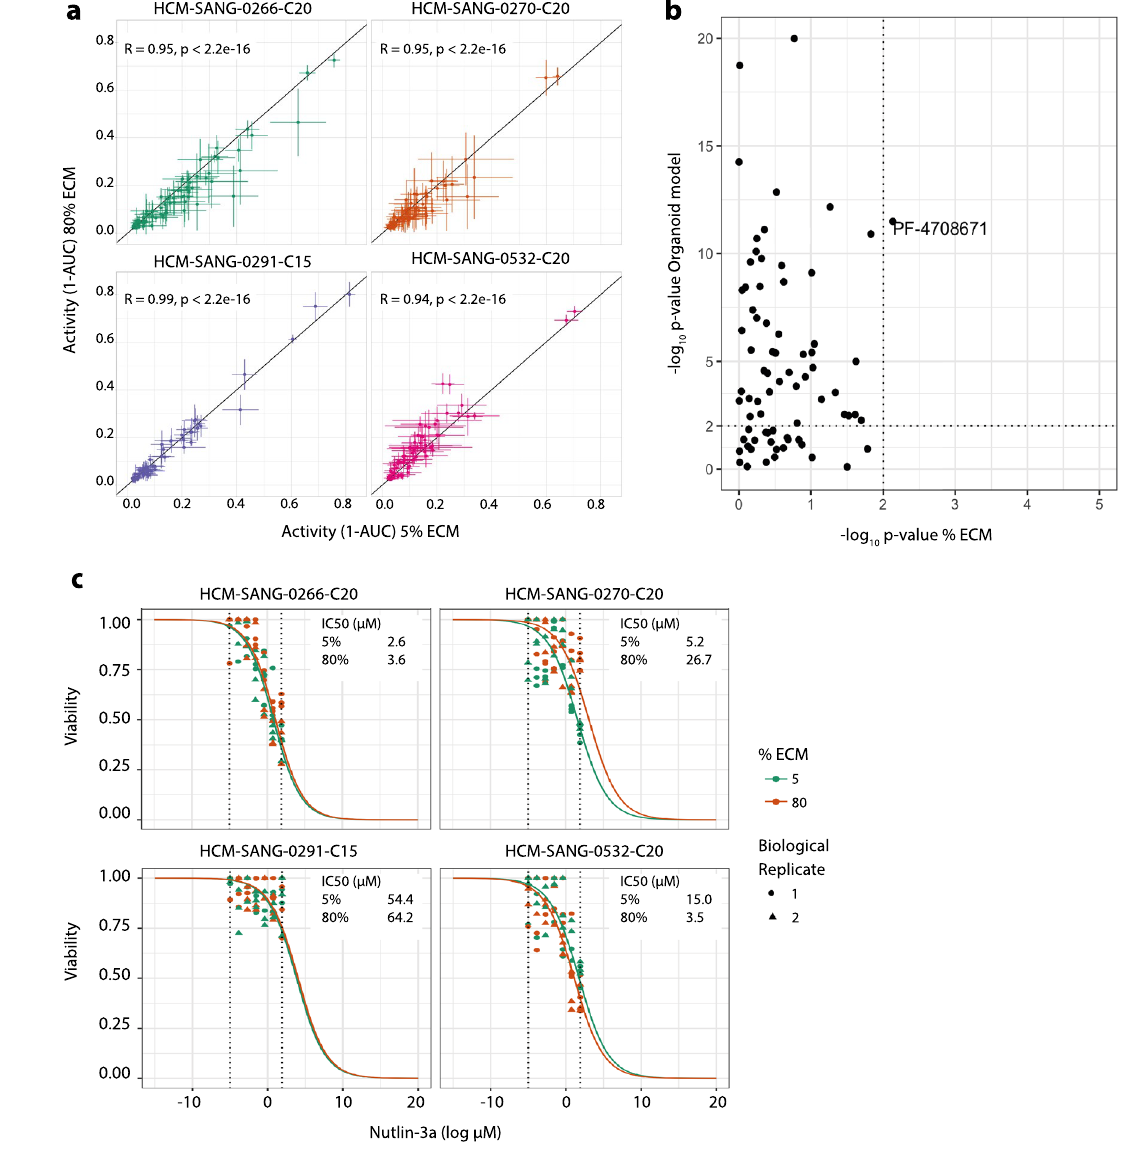
Figure 4. Drug response in standard vs 5% ECM conditions. ( a ) Sensitivity of four organoids to 72 anti- cancer drugs in 5% ECM (x-axis) and 80% ECM (y-axis). Each data point has error bars which represent the 95% confidence intervals using the t-statistic (n = 5–12 from two biological replicates). ( b ) ANOVA output of drug response and dependence on either culture condition or organoid model. Dashed lines are thresholds for statistical significance ( p < 0.01). ( c ) Representative dose response curves for the four organoid models when treated with Nutlin-3a. Cells cultured in 5% ECM prior to drug screening are coloured orange and 80% ECM are coloured green. Biological replicates are shown by different shapes and dotted lines indicate the Nutlin-3a concentration observed for screens performed in 2D cancer cell lines 28,30 (Supplementary Fig. S11). The distribution of the sgRNA and gene level fold changes were centred at 0 (Supplementary Fig. S11) indicating that coverage of the library at the sgRNA and gene level was maintained in both culture conditions, confirming no unexpected loss of transduced cells during the 3 week assay. There was a strong positive correlation between gene log-fold change values at both conditions (Pearson correlation R = 0.65), confirming that the identified fitness genes were consistent between culture conditions, particularly among the strong dependencies (Fig. 5b and Supplementary Fig. S11). We were able to confirm known gene dependencies in HCM-SANG-0273-C18. For example, this model is a microsatellite unstable (MSI) colorectal cancer model harbouring a BRAF V600E mutation and, as expected, knockout of BRAF led to a strong loss of viability in both 80% and 5% conditions (top 10% dependencies; Fig. 5c). Furthermore, knockout of WRN led to loss of viability in both conditions in keeping with its recent synthetic- lethal association with microsatellite instability 28 . This data indicates that CRISPR-Cas9 knockout screens can